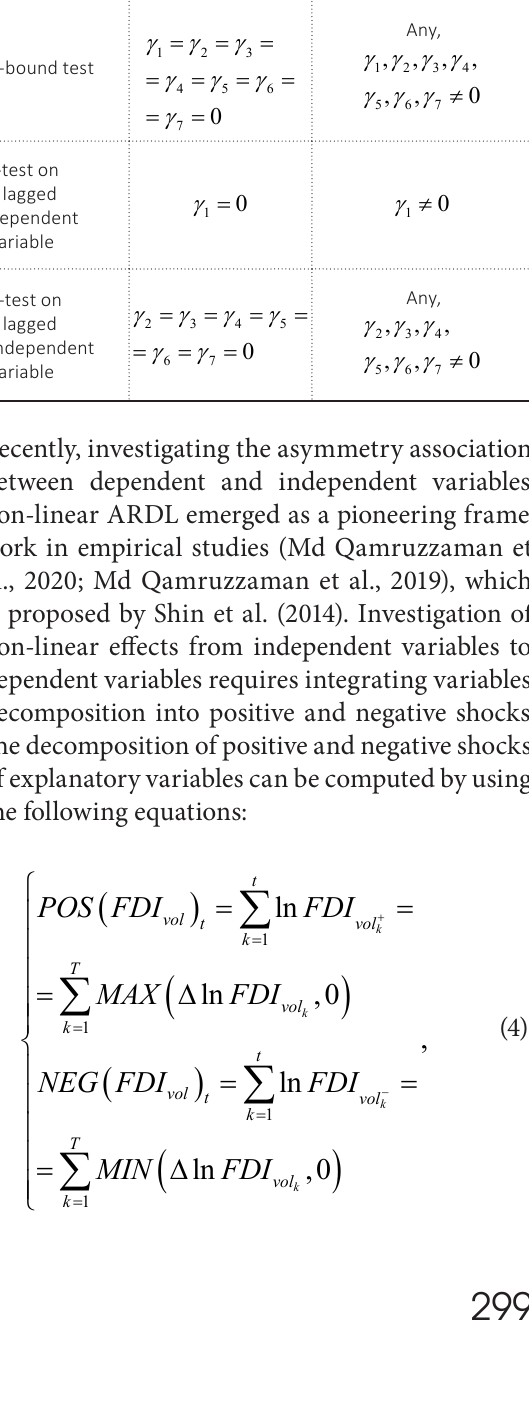
Table 2. Null hypotheses for all three tests Cointegration